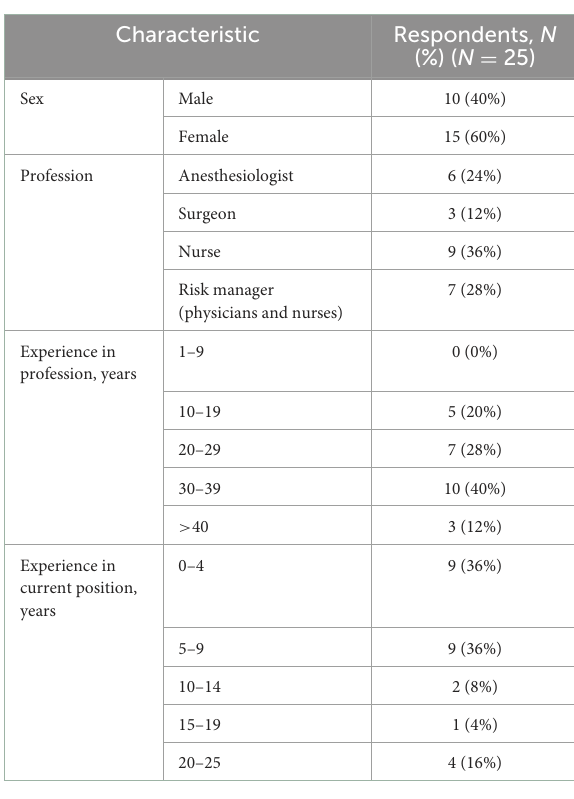
TABLE 3 Characteristics of